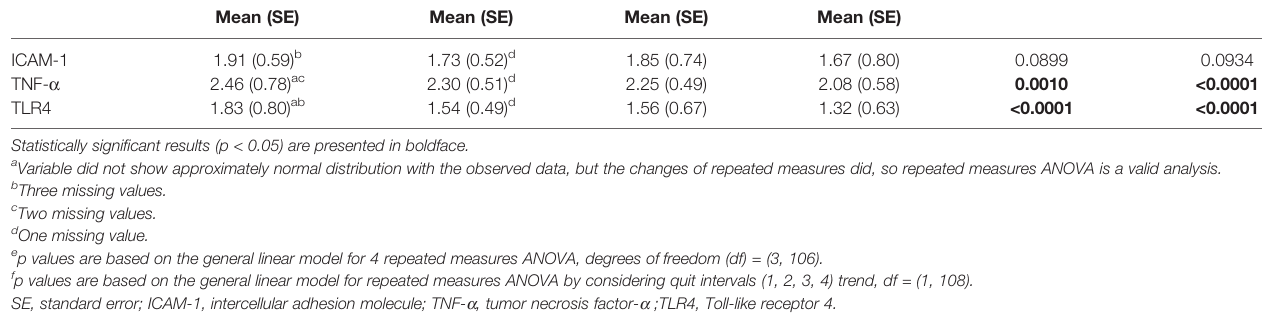
TABLE 5 | Comparisons of mononuclear cell markers in 87 smokers stop smoking (excluding 10 non-quitters) with repeated measures during follow-up. Variables BaselineDay 0, One week,